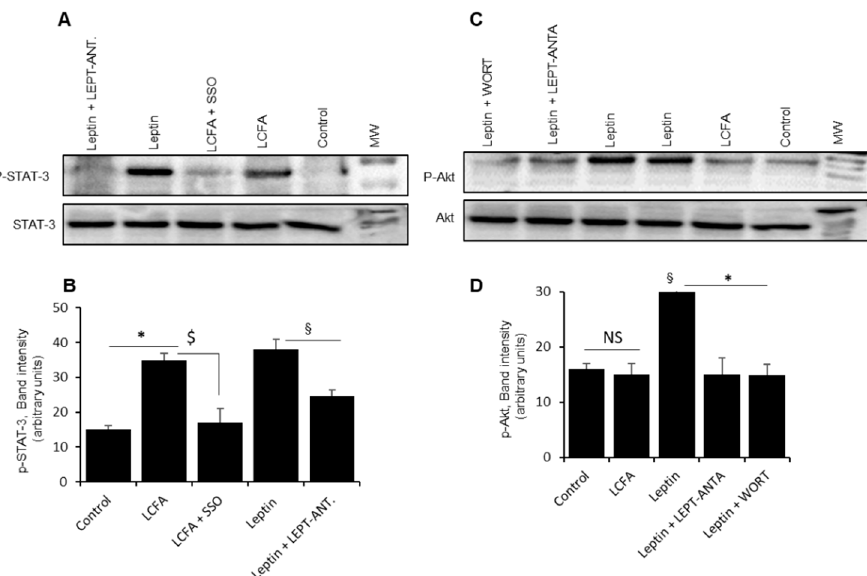
Figure 5. The effect of leptin on STAT-3 and Akt phosphorylation. ( A ) shows phosphorylated and unphosphorylated STAT-3. In ( B ), asterisk shows the significant differences ( p < 0.001) compared to control (untreated cells), whereas § and $ show significant differences ( p < 0.001) between two com- pared groups. ( C ) shows the Akt (phosphorylated and unphosphorylated). The TBC were treated or not (control) with different agents (leptin, 1 μ g/mL; LCFA, 25 μ M; leptin antagonist (LEPT- ANTA), 10 nM; wortmannin (WORT), 10 nM; sulfo- N -succinimidyl oleate (SSO), 10 μ M) for 20 min, and then TBC were lysed and processed for western blotting as described in Materials and Methods. In ( D ), asterisk shows the significant differences ( p < 0.001) compared with leptin treated cells. § shows significant values ( p < 0.001), compared with control (untreated) cells. NS represents not sig- nificant differences. Histograms ( B , D ) show the relative band intensity (arbitrary units) measured by densitometry of protein bands. Data were normalized with respect to band intensity of unphos- phorylated STAT-3 ( B ) and Akt ( D ), measured under similar conditions ( n = 5). Abbreviation: MW, molecular weight.